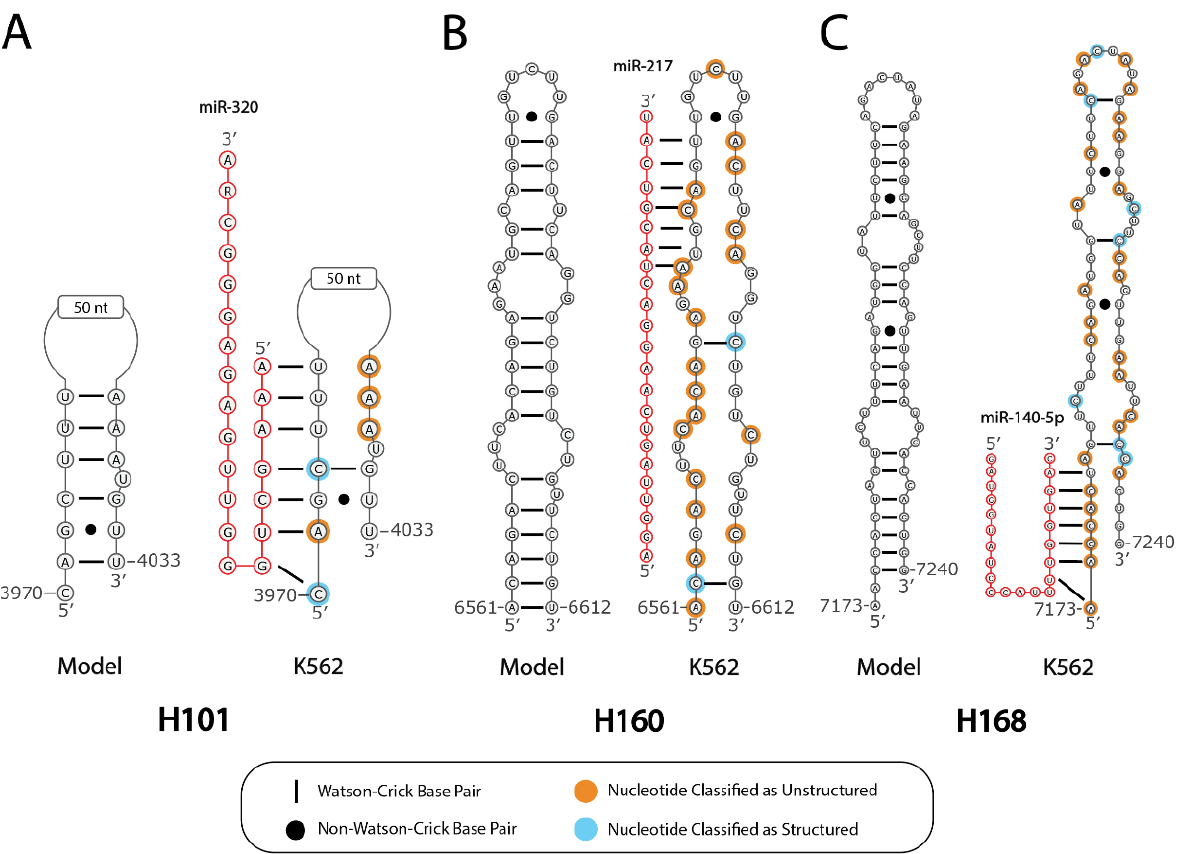
Figure 4. Structural loss in K562-MALAT1 improves accessibility of miRNA-binding sites. Three hairpin-miRNA interactions are shown: ( A ) miR-320 seed binding to H101, ( B ) miR-217 seed binding to H160, and ( C ) miR-140-5p seed binding to H168. Depicted is the predicted structure of each hairpin in noncancerous cells (“Model”) adjacent to the hairpin structure in K562-MALAT1 (“K562”), where the relevant base pairs are removed according to our analysis of DMS-Seq data. Nucleotides with an orange background are classified as unstructured and nucleotides with a blue background are classified as structured. The binding of a given miRNA (red) seed region to the K562-MALAT1 hairpin is shown. The nucleotide R denotes a G and A residue in miR-320a and miR-320b,